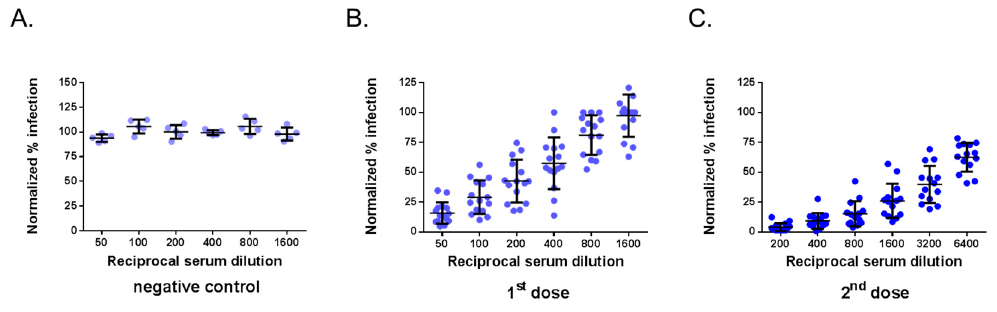
Figure 2. Plaque-reduction neutralization test on anti-Zika virus immune sera. The neutralizing ability of mouse serum specimens against MR766 GFP was determined by plaque-reduction neutralization test (PRNT) on Vero cells. Samples of anti-ZIKBeHMR-2 immune sera were tested individually. Serum specimens were two-fold serial diluted starting at a 1:50 dilution. The results are shown normalized to the 100% infection achieved with MR766 GFP without serum. In ( A ), the immune sera of BALB / c mice inoculated with heat-inactivated ZIKBeHMR-2 served as a negative control (negative control). In ( B ), immune sera of BALB / c mice that received a single dose of ZIKBeHMR-2 (5 log PFU) (1 st dose). In ( C ), immune sera of BALB / c mice that received two doses of ZIKBeHMR-2 (5 log PFU) with an interval of 6 weeks (2 nd dose).